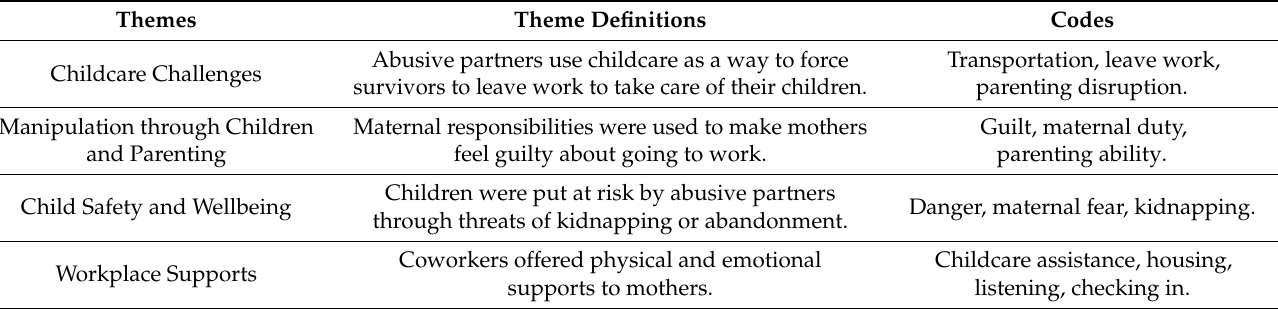
Table 1. Themes, theme definitions, and